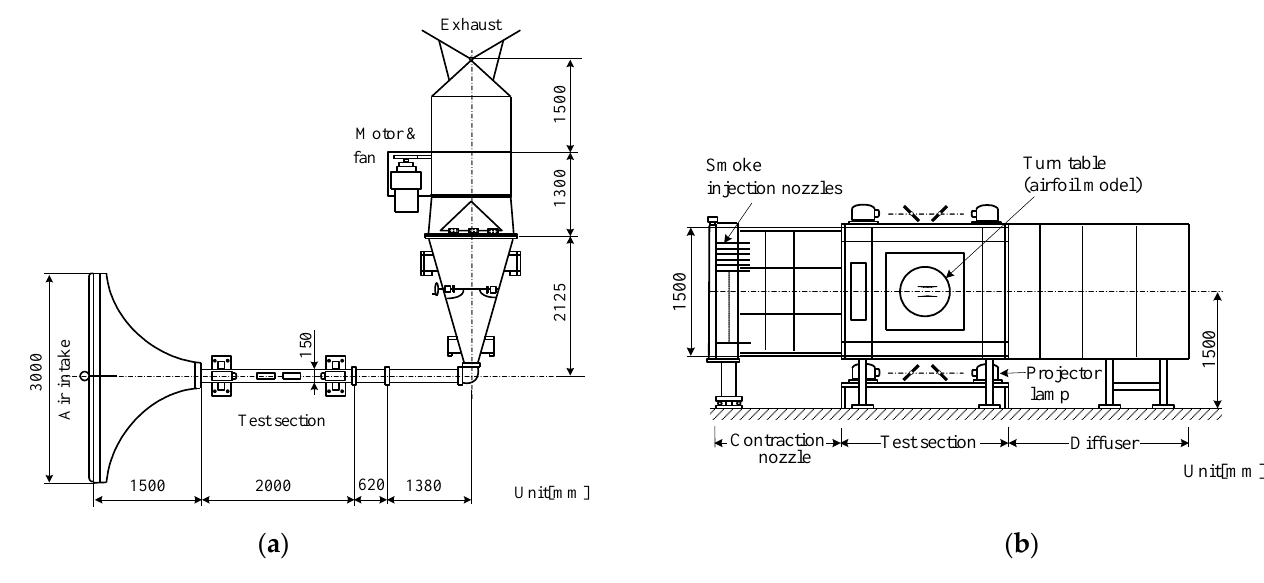
Figure 1. Overview of the low-speed wind tunnel: ( a ) top view; ( b ) side view.